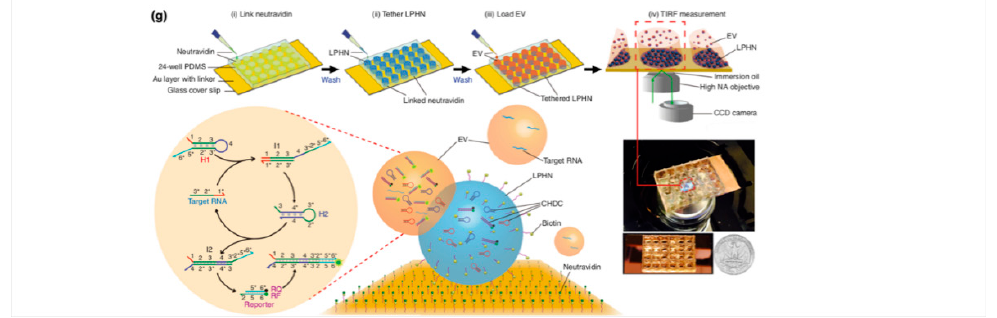
Figure 3. ( a ) Schematic illustrating the design and fabrication of a biochip by using the MEA technique. The patterned channels with Indium ion oxide (ITO)-electrodes provide a connected network enabling to guide the neurite outgrowth and measure the neurological signals through impedance signals. (Reprinted with permission from [85] Copyright (2018) ACS publications). ( b ) Illustrate the preparation of A β 42-immobilized graphene-based biosensors. The magnetic graphene nanomaterials assembled on an Au electrode provide a re-usable biosensor for rapidly detect the Alzheimer’s disease-related biomarker. (Reprinted with permission from [92] Copyright (2016) Springer Nature Limited.) ( c ) Schematic illustrating the detection of a Parkinson’s disease (PD) biomarker ( α -synuclein) through a liquid crystal biosensor. After the deoxyribonucleic acid (DNA) aptamer on the biosensor surface capturing the α -synuclein, the bright view of liquid crystal could be observed in the polarized microscope. (Reprinted with permission from [93] Copyright (2020) Royal Society of Chemistry) ( d ) Schematic images of a soft flexible cardiac biosensor. The real-time heart rate and electrocardiogram (ECG) waveforms from this biosensor could be transmitted to smart phone to display a visible signal on an app. Additionally, the flexible polyurethane substrate endows biosensor with an ability to deform under the mechanical twist and bend force. (Reprinted with permission from [94] Copyright (2018) Springer Nature Limited.) ( e ) A heart-on-a-chip was assembled by an electrode and PDMS channels for culturing cardiac cells. The nanopillars on Au electrodes could be as a transducer to puncture into cellular membrane for the activation ATP-dependent K + channels and promotion of membrane repolarization. (Reprinted with permission from [95] Copyright (2020) ACS publications) ( f ) Illustration of a prostate cancer biosensor integrated a microfluidic chip and vascular endothelial growth factor (VEGF)- and prostate-specific antigen (PSA)-immobilized electrodes. The biochip o ff ers a high sensitivity for the detection of prostate cancers and their circulating tumor cells and an easy quick method to analyze by using a UV-Vis absorbance within one hour. (Reprinted with permission from [96] Copyright (2017) Ivy spring International Publisher) ( g ) Schematic illustrating the principle and operation of the biochip by linking neutravidin with a tether lipid-polymer hybrid nanoparticle (LPHN) and loading extracellular vesicle (EV) on an Au layer. This technique enables to distinguish patients with early- or late-stage pancreatic cancers. (Reprinted with permission from [97] Copyright (2017) Springer Nature